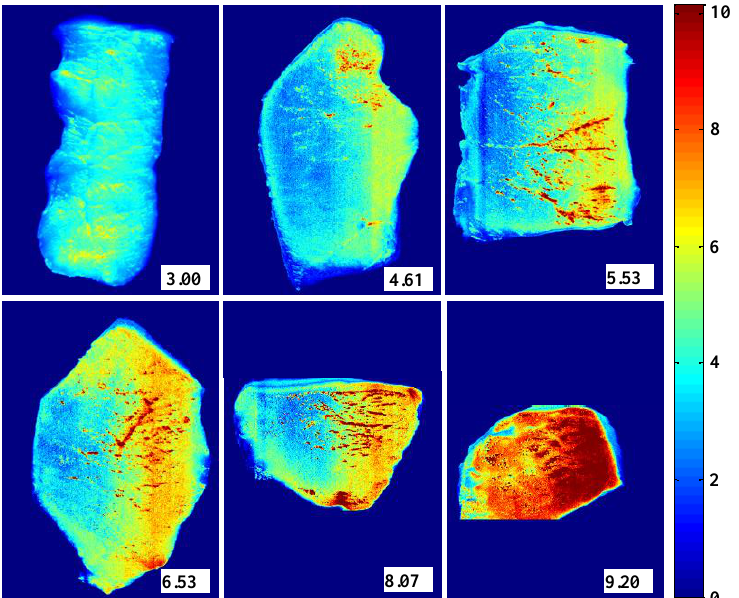
Figure 6. Visualizing maps of TVC in different samples at different levels of contamination with different TVC values of 3.00, 4.61, 5.53, 5.53, 8.07, 9.20 log CFU/g respectively from top to bottom and left to right.